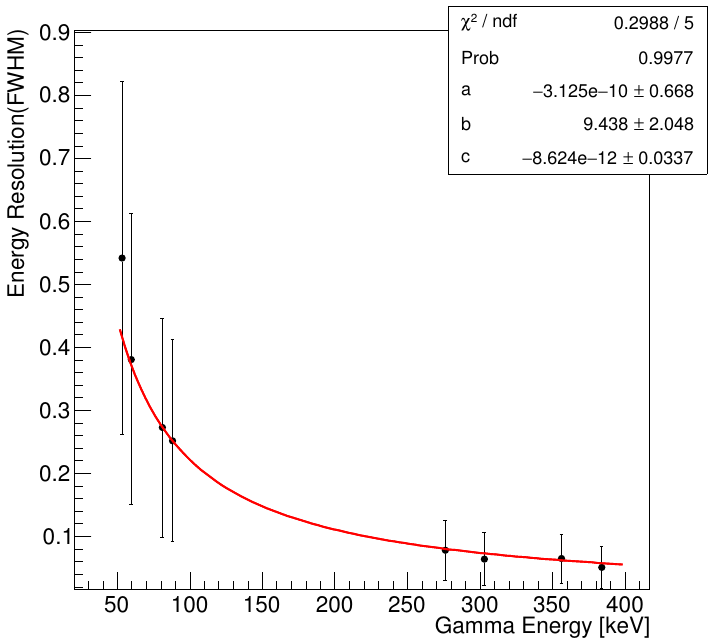
Figure 8. Dependence of Energy Resolution on Gamma Energy from Radioactive Sources: 241 Am, 109 Cd, and 133